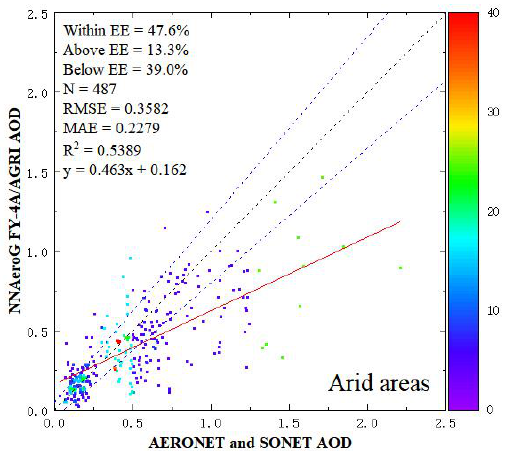
Figure 6. Scatterplots of the AOD retrieved using FY-4A/AGRI over arid areas versus AERONET and SONET reference data. The blue lines are the EE envelopes for AOD of ± (0.05 + 15%). The red line is the linear fitting line of AOD. The black line represents the 1:1 line.